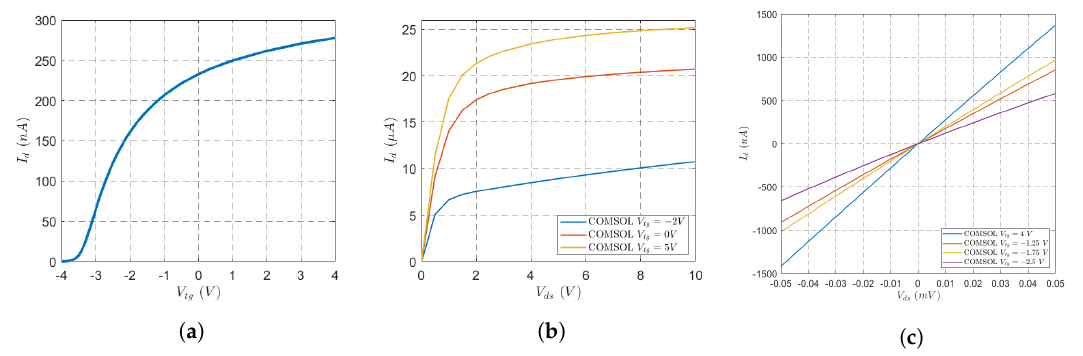
Figure 10. Transfer characterstic for V ds = 10 mV ( a ), output characteristic for different values of V tg ( b ), output characteristic for small values of V ds and different values of V tg ( c ).